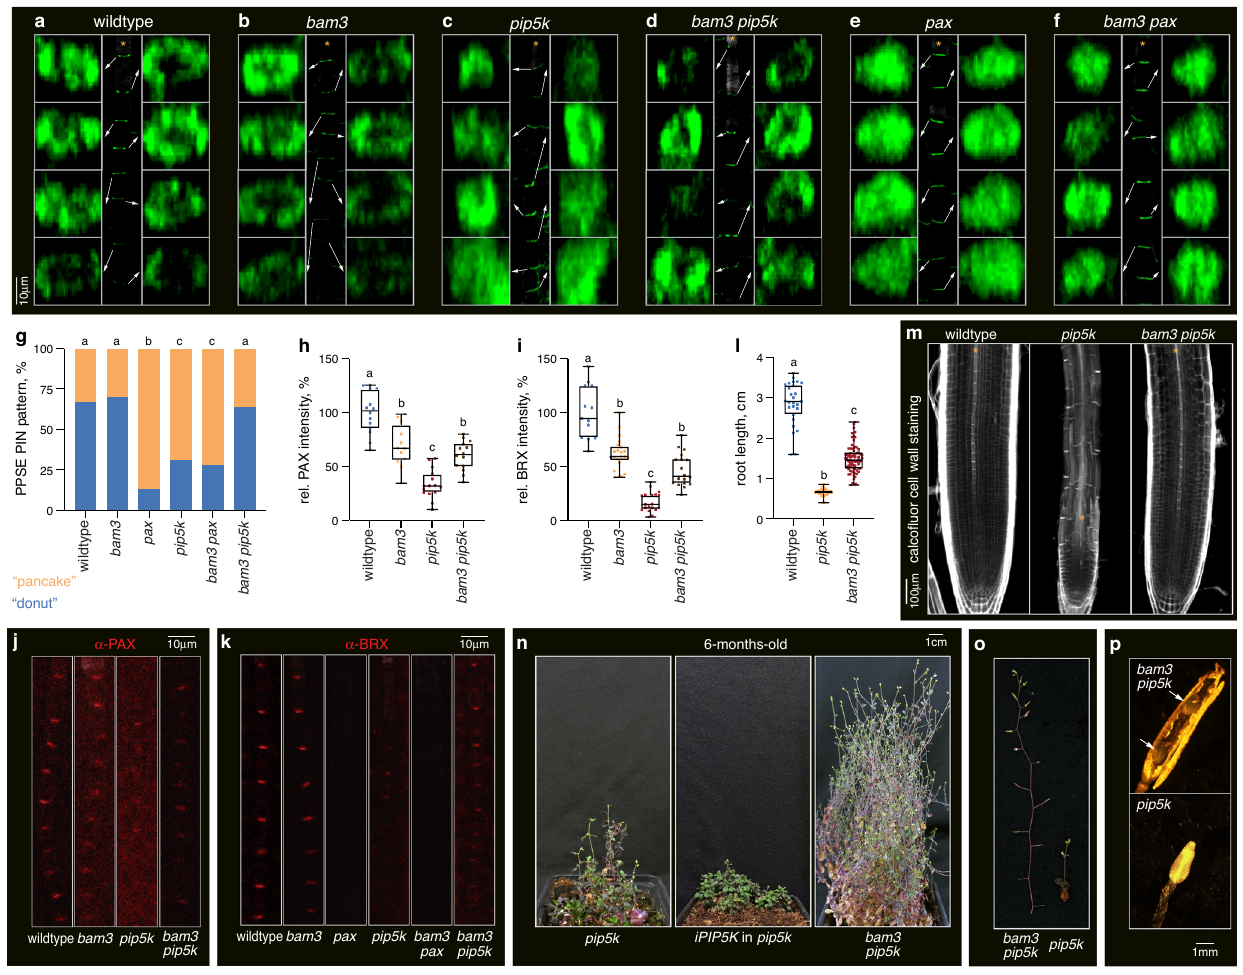
Fig. 5 | Antagonism between BAM3 signaling and PIP5K determines PAX polarity. a – f Confocal microscopy images of PIN1 localization (anti-PIN1 immu- nostaining, green fl uorescence, 3D reconstruction) in developing PPSE cell fi les (calco fl uorstaining,gray fl uorescence;asterisks)of5-day-oldseedlingsofindicated genotypes. Center panels: overview; Side panels: magni fi ed images of individual PPSE rootward membranes, with positions indicated by arrows. g Scoring of sub- cellular PIN patterning in developing PPSEs of 5-day-old seedlings of indicated genotypes, determined by anti-PIN1 immunostaining. n =19 – 51 roots, 210 – 540 PPSEs per genotype; Statistically signi fi cant differences (lower case letters) were determinedbyFisher ’ sexacttest, p <0.0001. h ,AbundanceofPAX,determinedby anti-PAX immunostaining in developing PPSEs of 5-day-old seedlings of indicated genotypes. n =12 – 15 roots, 96 – 135 PPSEs per genotype; Statistically signi fi cant differences were determined by ordinary one-way ANOVA, p <0.0005. i AbundanceofBRX,determinedbyanti-BRXimmunostainingindevelopingPPSEs of 5-day-old seedlings of indicated genotypes. n =13 – 21 roots, 130 – 230 PPSEs per